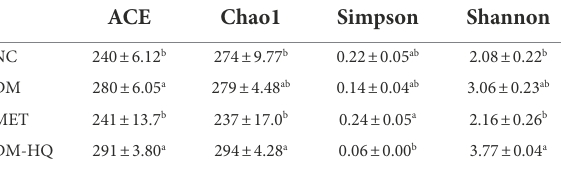
TABLE 1 Effects of HQLHS on α diversity of cecal microbiota in diabetic mice. ACE Chao1 Simpson